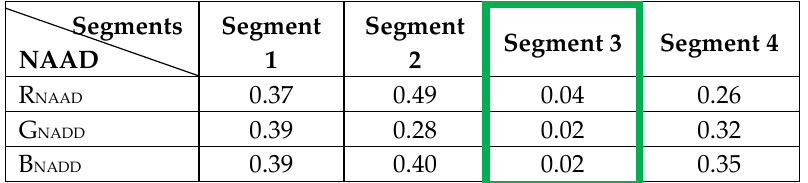
Figure 1. A sample image from the UPenn dataset [49] and its four resulting segments: ( a ) original image, ( b – e ) segment 1-4 . Table 1. Normalised Average Absolute Difference (NAAD) values of different colour components of the image segments.